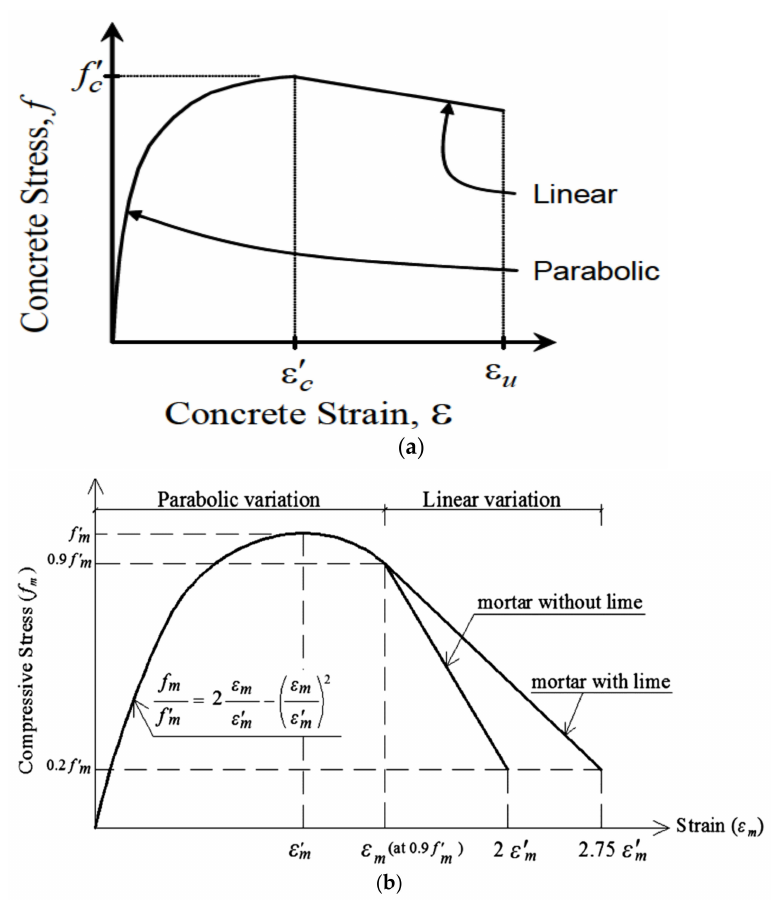
Figure 1. ( a ) Simple concrete stress-strain model; ( b ) idealized stress-strain model for